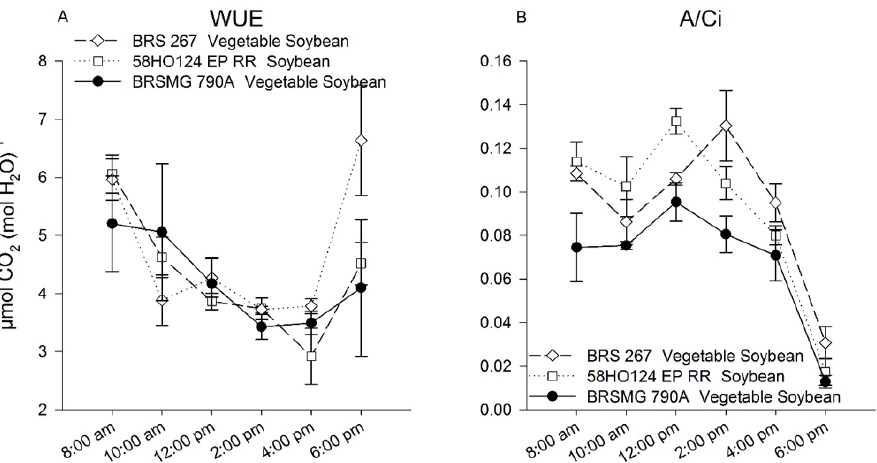
Figure 2. Water use efficiency (WUE, μ mol CO 2 (mol H 2 O) − 1 ) ( A ) and carboxylation efficiency ( A / Ci ) ( B ) of vegetable and type soybean cultivar grain soybean cultivars. Botucatu, SP, Brazil, 2021. Plants of cultivar vegetable ‐ type BRSMG 790A were less efficient than those of veg ‐ etable ‐ type BRS 267 and type soybean cultivar grain 58HO124 EP RR in terms of A / Ci (Figure 2B). These results are consistent with those for CO 2 assimilation rate, which oc ‐ curred at 12:00 p.m. for type soybean cultivar grain 58HO124 EP RR and 2:00 a.m. for vegetable ‐ type BRS 267. 3.2. CO 2 Assimilation Response Curve as a Function of PPFD PFFD had a varied effect on different cultivars (Figure 3). Table 3 shows significant differences in light compensation point, light saturation point, and dark respiration amongst cultivars, indicating that both vegetable and type soybean cultivar grain required distinct PPFD to absorb CO 2 and accumulate dry matter. Figure 3. Net CO 2 assimilation rate ( A , μ mol m − 2 s − 1 ) as a function of photosynthetic photon flux density (PPFD, μ mol m − 2 s − 1 ) of vegetable and type soybean cultivar grain. Botucatu, SP, Brazil, 2021.